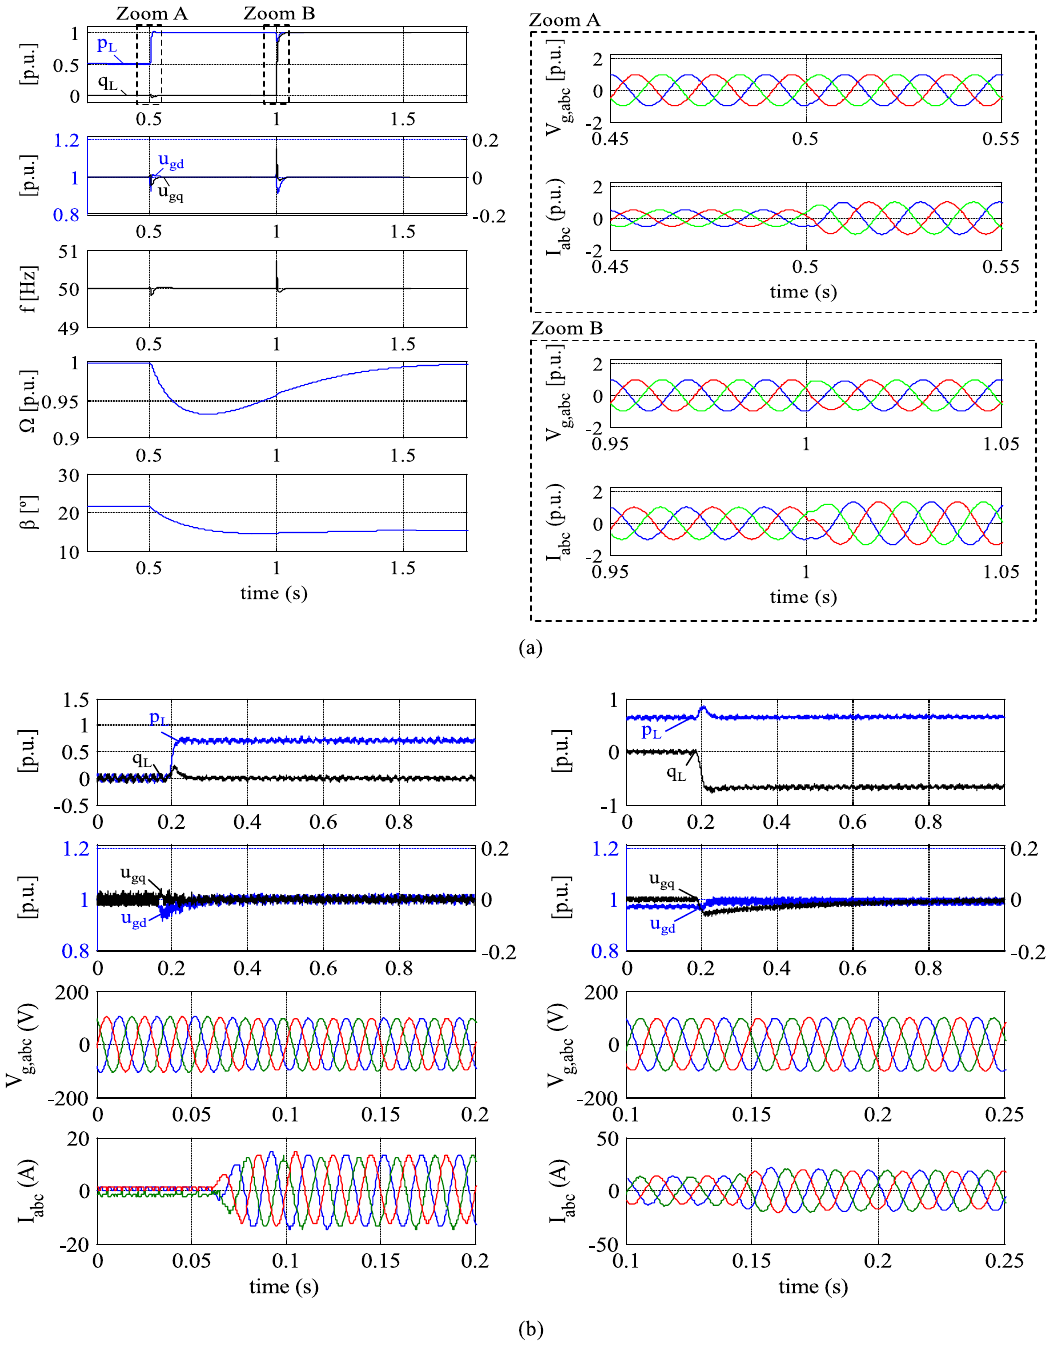
Figure 8. Load step response in: ( a ) A simulation ( b ) A real-time